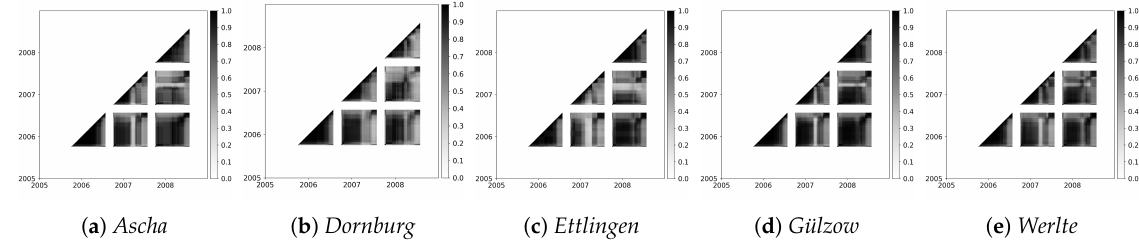
Figure 7. TDCCs of parameter rankings for AGB based on the daily main effects for different simulation days differentiated for each study site. A higher TDCC indicates greater similarity of the parameter rankings. The dark areas indicate periods during which the parameter rankings were similar for different simulation